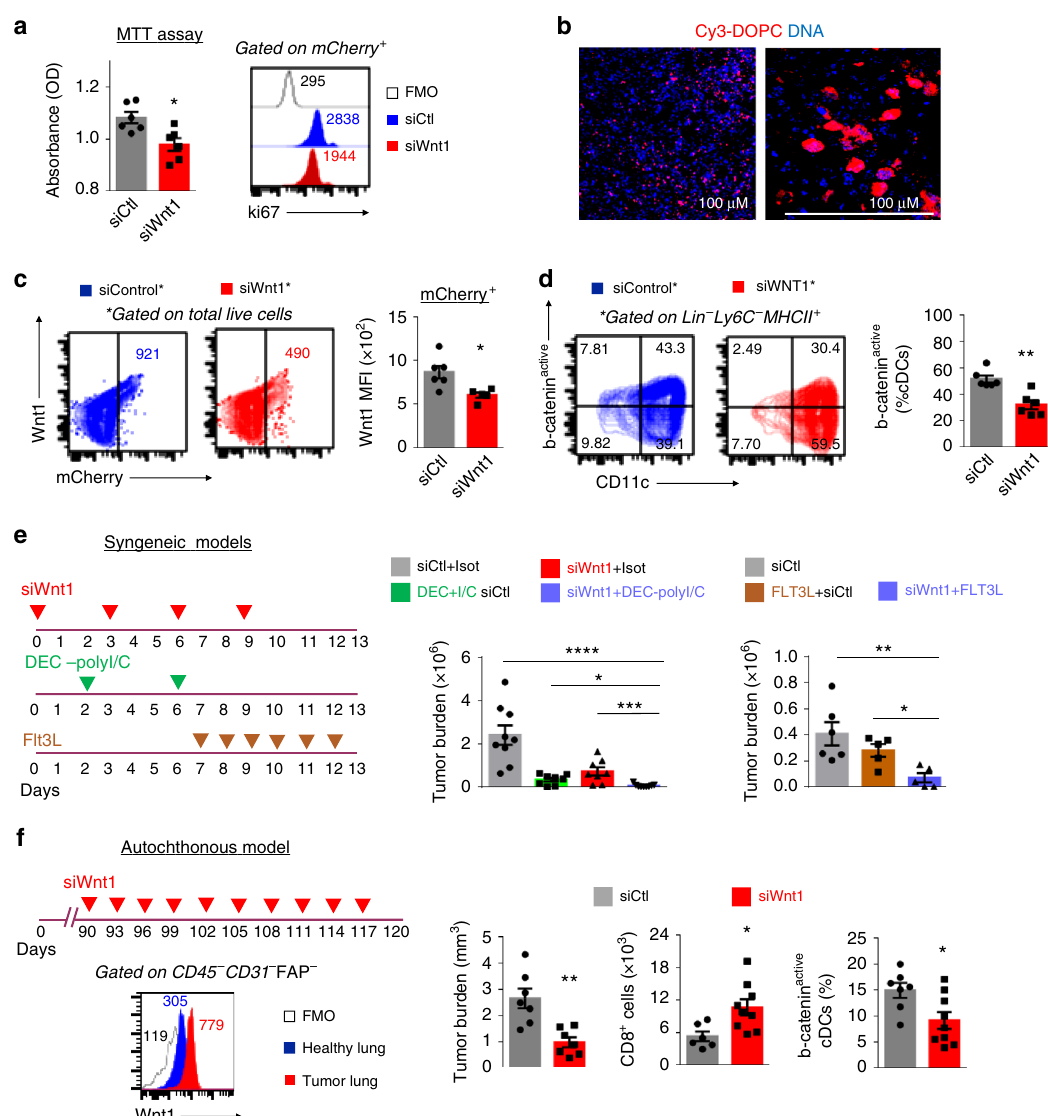
Fig. 6 RNA interference against Wnt1 rescues cDCs from b-catenin activation and synergizes with DC-targeted therapies. a In vitro proliferation of Wnt1 overexpressing LLC cells in the presence of siWnt1 RNA nanoliposomes. MTT assay (left) and Ki67 expression (right). b Confocal photos showing lung tumor localization of intraperitoneal administered Cy3 loaded DOPC nanoliposomes. c siWnt1 or siControl RNA nanoparticles were administered to mice bearing Wnt1 overexpressing OVA-LLC lung tumors in vivo. FACS contour plots of Wnt1 expression by mCherry + LLC and mCherry − tumor stroma cells (Left). Cumulative data (right). d Representative FACS contour plots depict active b-catenin expression by cDCs (left). Cumulative data (right). e In vivo lung tumor growth. siWnt1 was given therapeutically either as single agent or in combination with a-DEC205-OVA plus polyI/C (left) or Flt3Ligand (right). f Immunotherapeutic ef fi cacy of siWnt1-loaded nanoparticles in autochthonous urethane-induced lung adenocarcinomas. siWnt1 or siControl RNA nanoparticles were administered to mice bearing established urethane-induced lung tumors in vivo (left up). Representative FACS histogram plots of Wnt1 expression by CD45 − CD31 − FAP − cells (left bottom). Cumulative data showing tumor burden, numbers of lung T cytotoxic cells and b-catenin active cDCs (right). c – f Data are representative or cumulative of at least two independent experiments with 4 – 9 mice per group. Error bars represent mean with SEM. * p < 0.05; ** p < 0.01, Mann – Whitney. Source data are provided as a Source Data fi